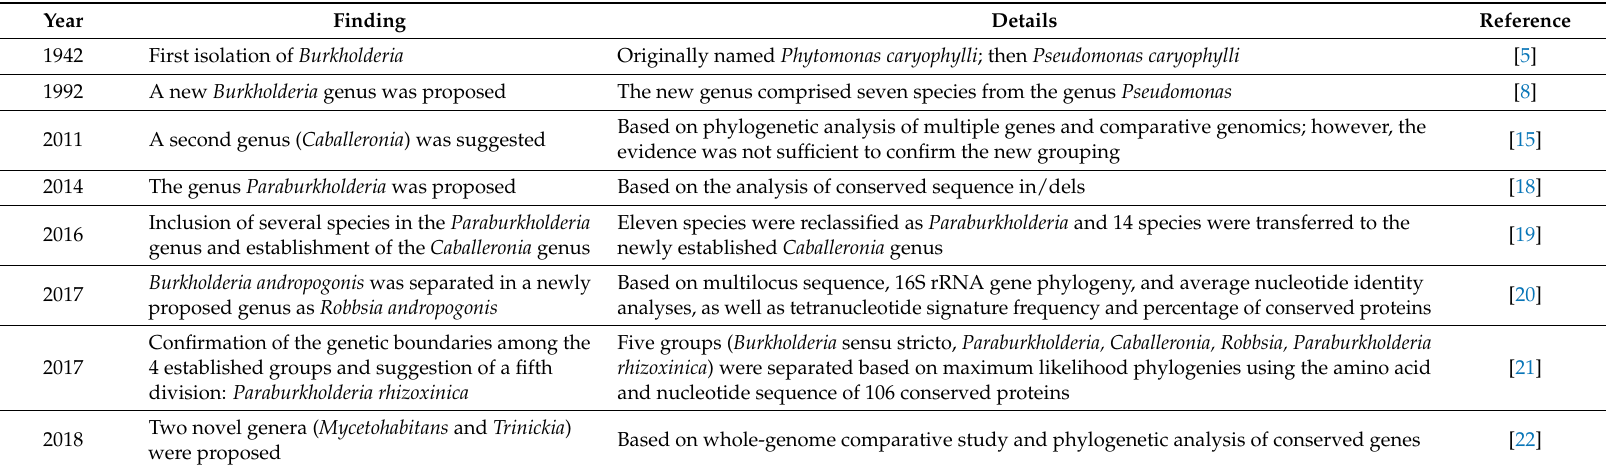
Table 1. An overview of the major rearrangements and updates in the taxonomy of Burkholderia